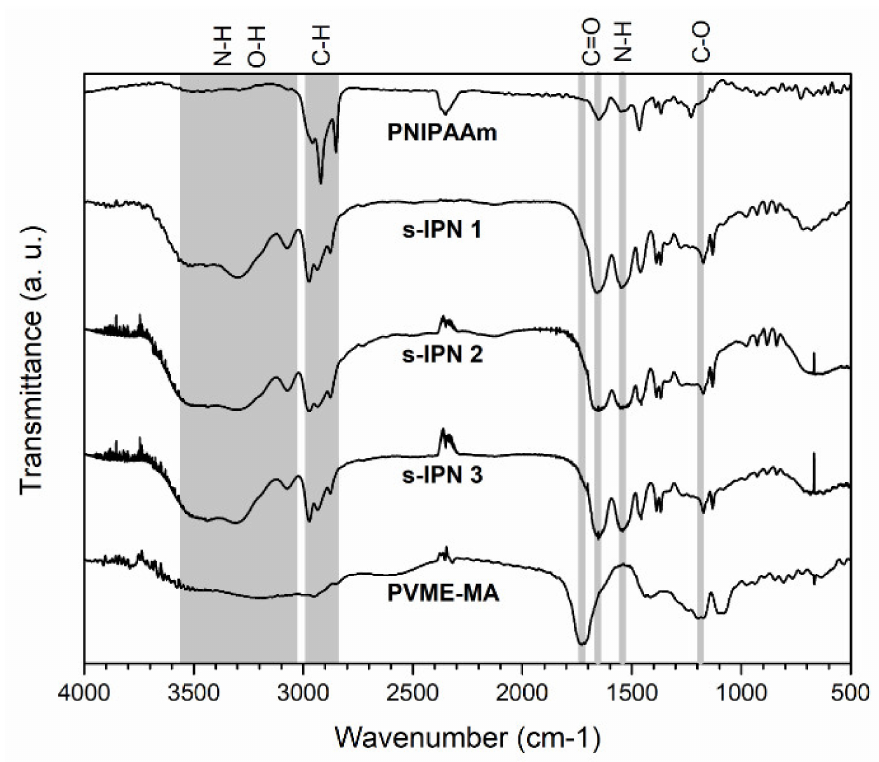
Figure 2. FTIR spectra of PMVE-MA, pristine PNIPAAm hydrogel, and s-IPN